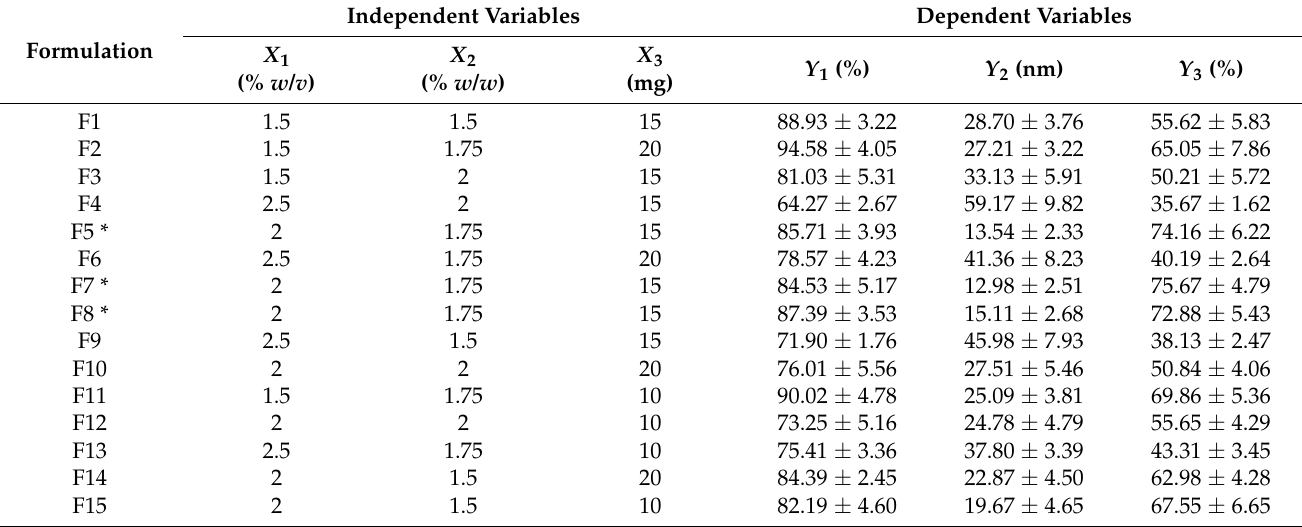
Table 2. PRZ-PMMs experimental runs, causal variables and observed responses according to Box-Behnken statistical design.